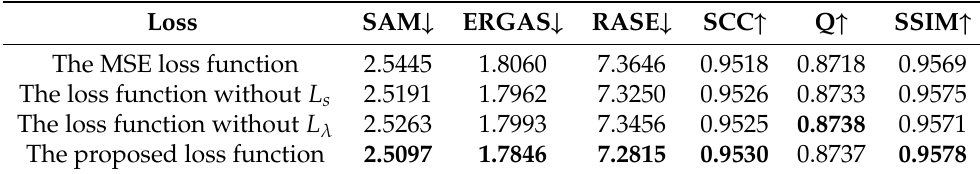
Table 4. Ablation study of different loss functions on the Ikonos